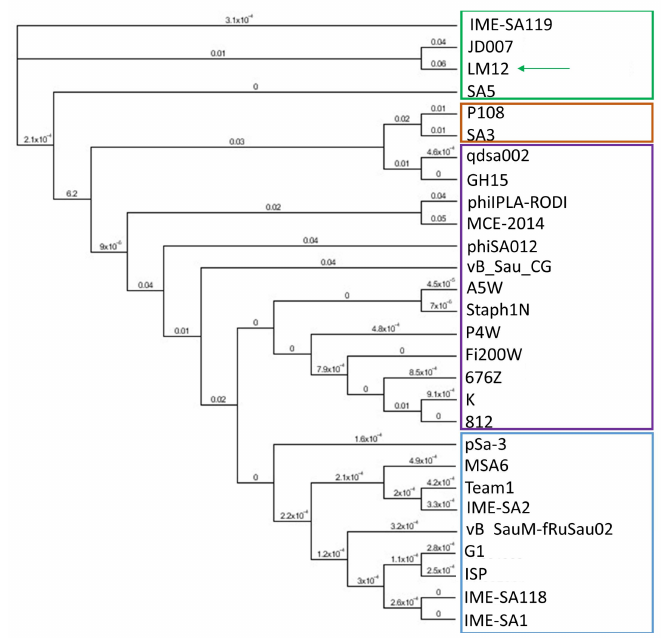
Figure 3. Phylogenetic tree from LM12 genome and its most closely related phage genomes. The tree was generated with a Maximum-Likelihood phylogenetic (PHYML) algorithm, with a bootstrapping of 100. Four groups are indicated (green, orange, purple, and blue), and arrows indicates phage LM12. The figure was performed using Geneious